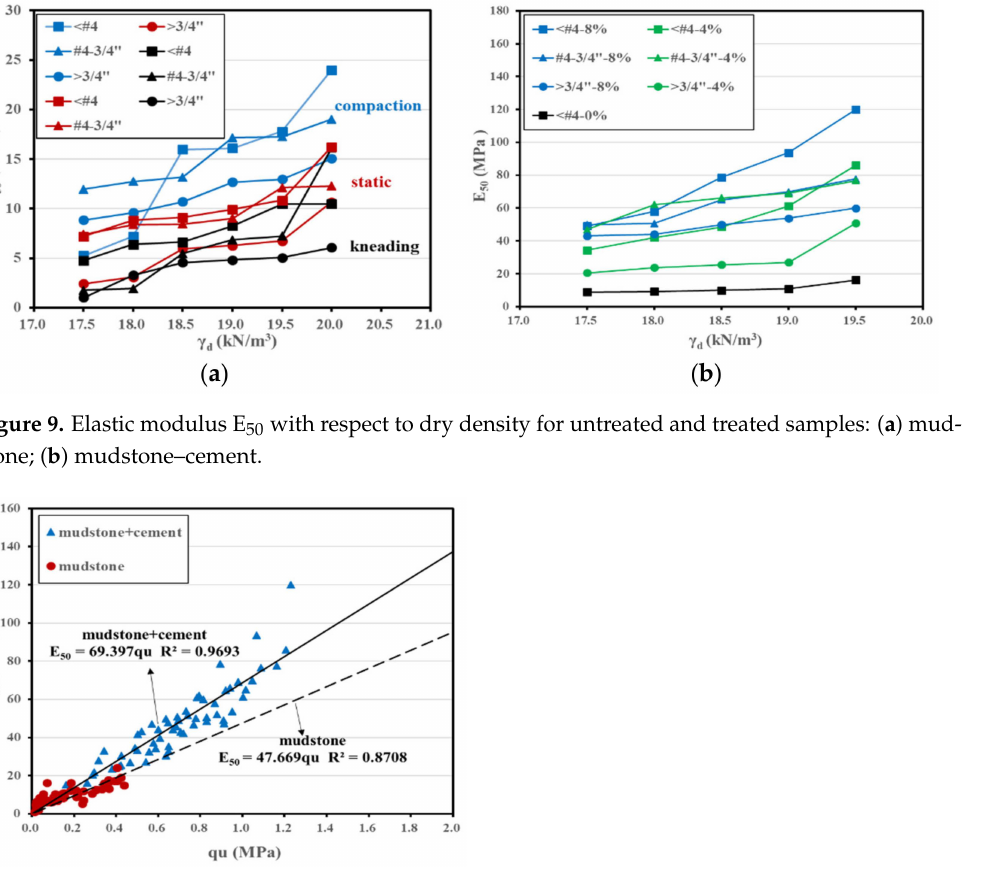
Figure 10. The relationships between q u and E 50 values based on mudstone and mudstone– cement